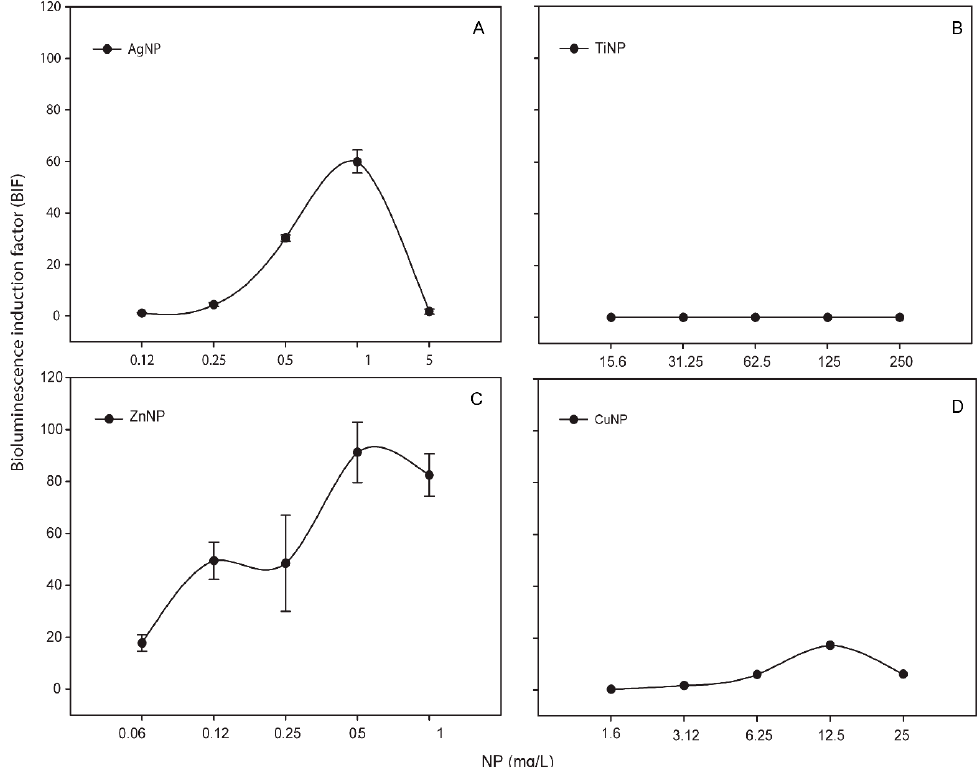
Figure 1. Bioluminescence response of Synechococcus elongatus sp. PCC7942 pBG2120 exposed to metallic NPs after 4 h of exposure. ( A ) Synechococcus elongatus sp. PCC7942 pBG2120 exposed to AgNPs; ( B ) Synechococcus elongatus sp. PCC7942 pBG2120 exposed to TiNPs; ( C ) Synechococcus elongatus sp. PCC7942 pBG2120 exposed to ZnNPs; ( D ) Synechococcus elongatus sp. PCC7942 pBG2120